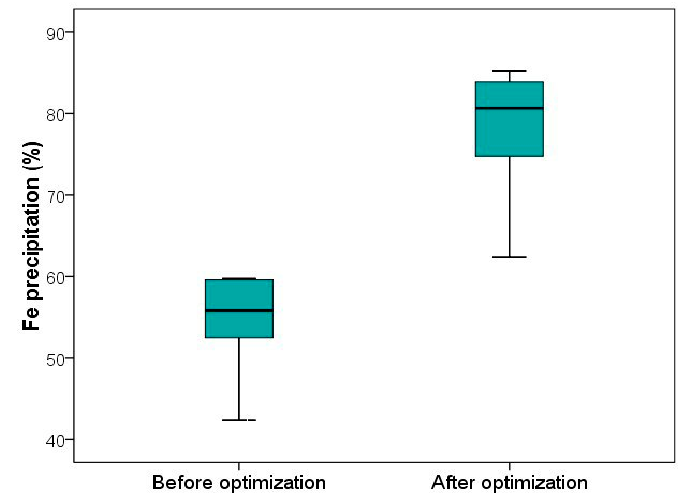
Figure 10. A comparison between Fe precipitation before and after optimization in the Jarosite precipitation process (JPP) of the BZSC plant.